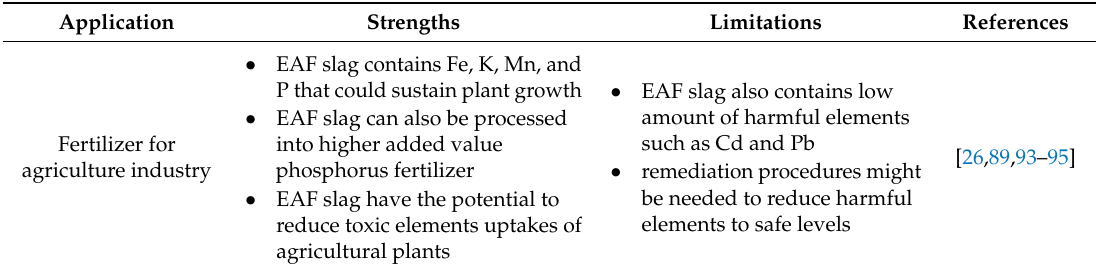
Table 7. Strengths and limitations of incorporating EAF slag in fertilizer for agriculture